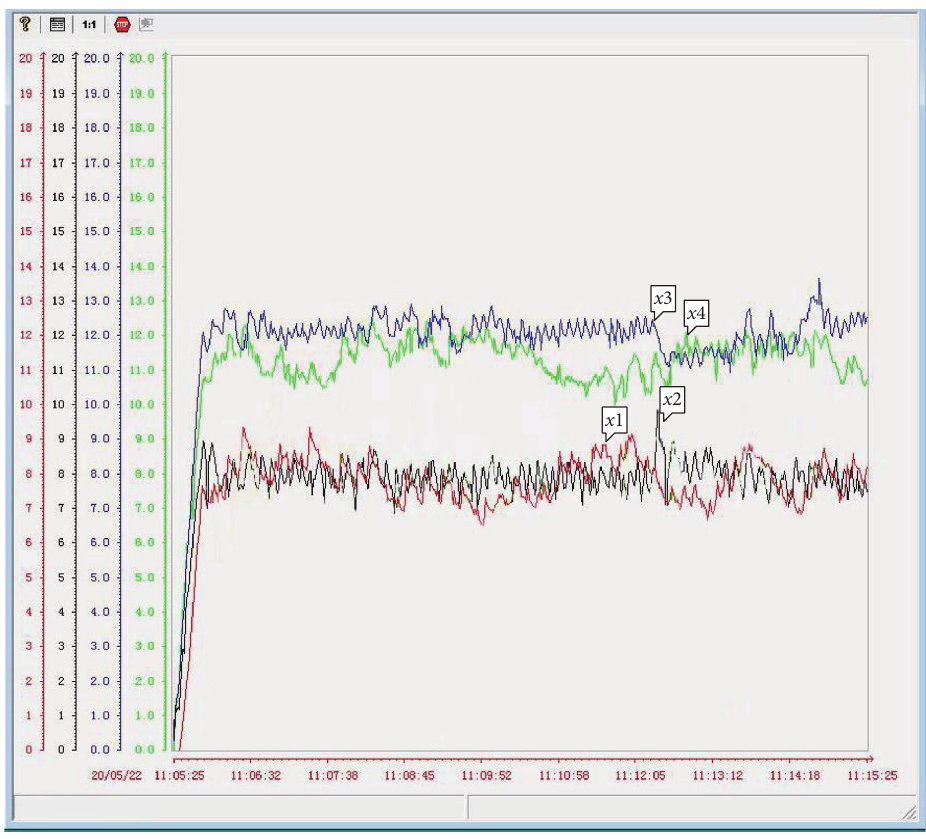
Figure 7: Experimental liquid levels under the finite-time